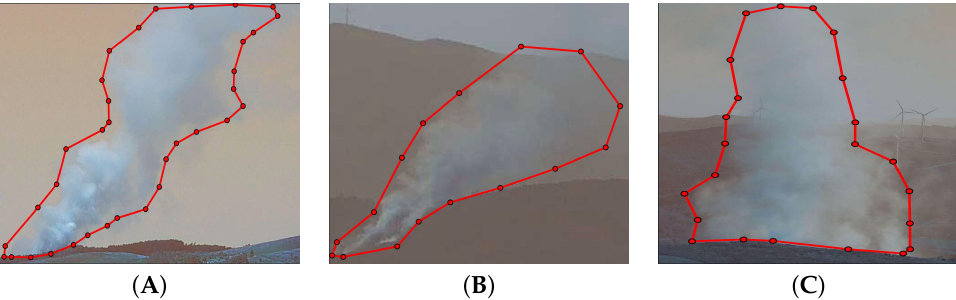
Figure 2. Different types of segmented fire smoke columns. ( A ) Example of smoke labeled as hrz . ( B ) Smoke labeled as mid . ( C ) Smoke labeled as low